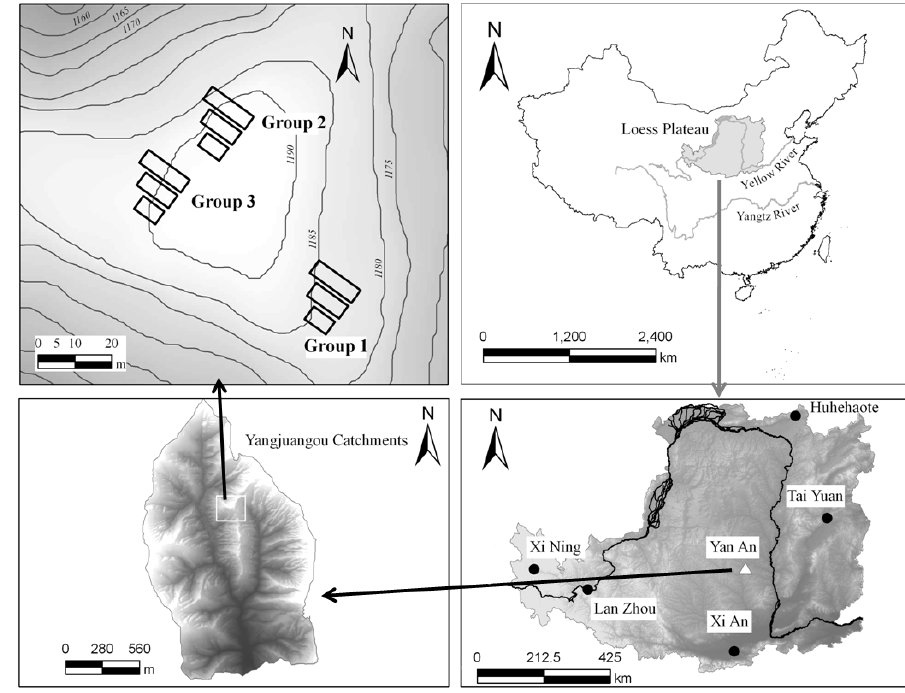
Fig. 1. Location of the study area and distribution of the three runoff plot groups